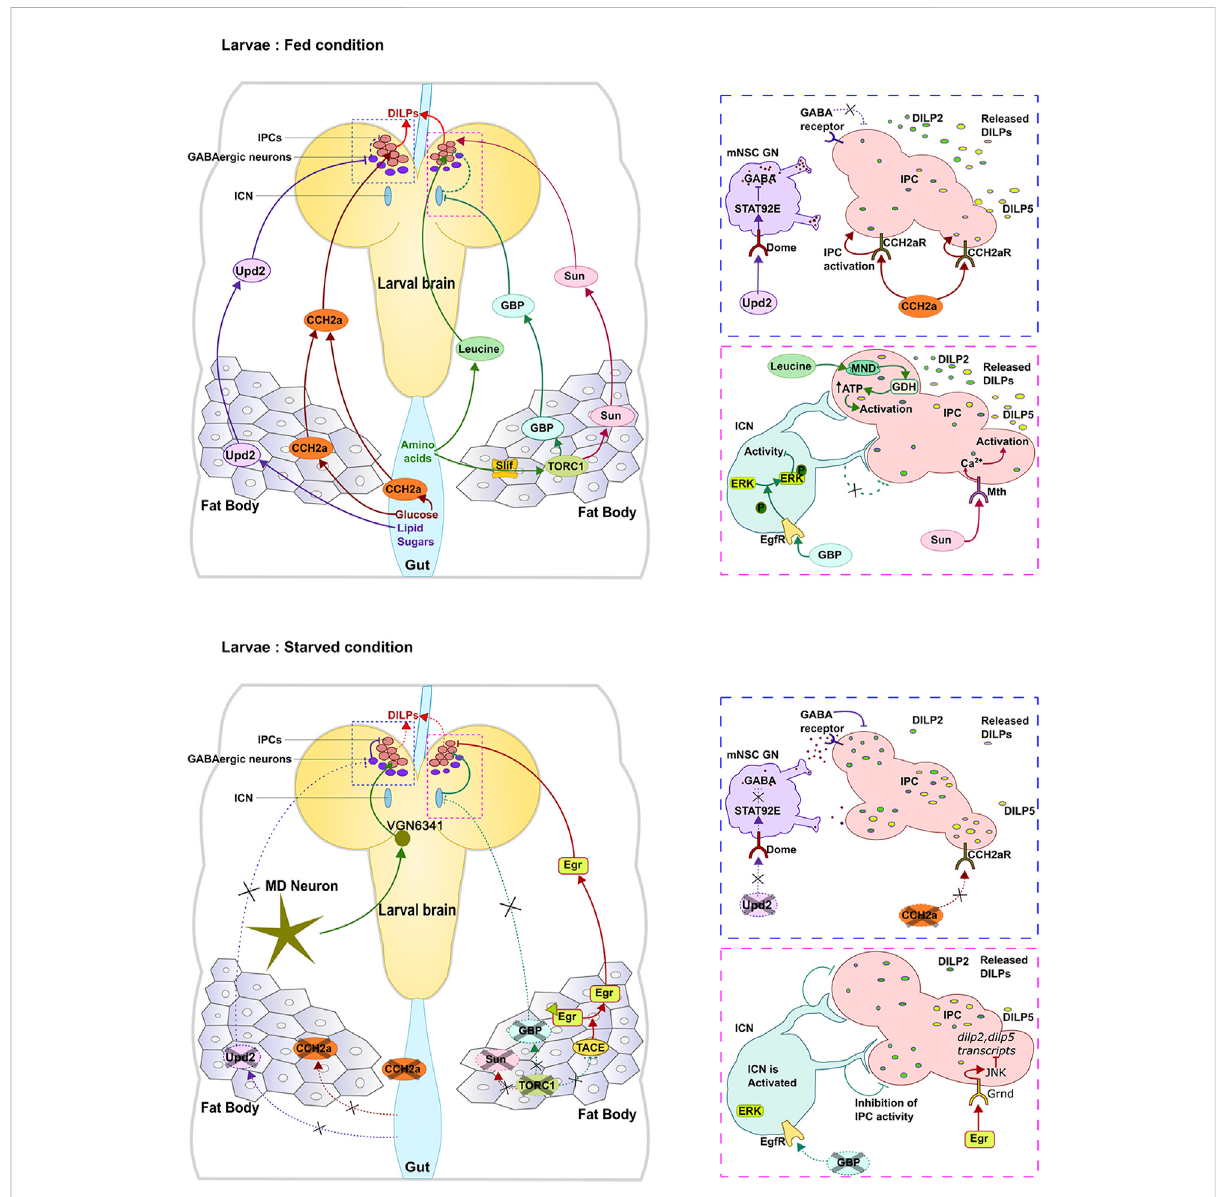
FIGURE 1 Regulation of IPCs in the larval brain under fed and starved conditions. Different nutrients lead to release of different signaling molecules from the fat body and gut to regulate DILP